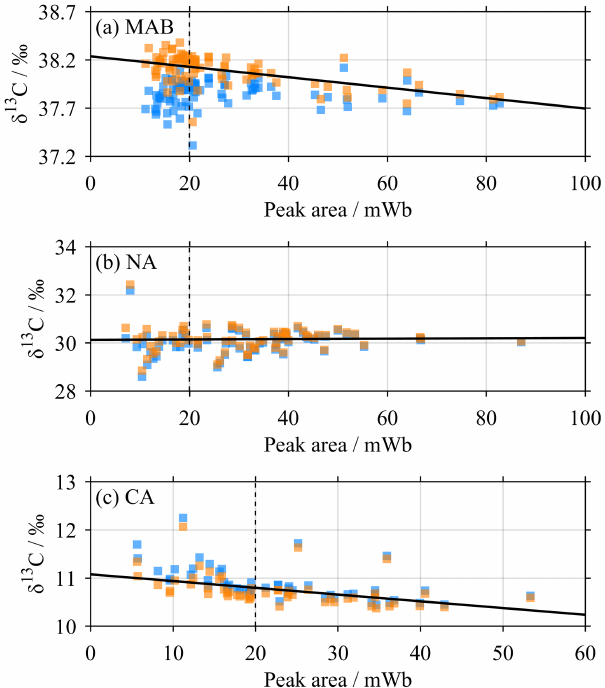
Figure 4. The blank correction for the standards. Each panel shows relationships between peak area and δ 13 C for (a) MAB, (b) NA and (c) CA before (blue) and after (orange) blank correction. The solid black lines are linear least-squares regressions for the data af- ter blank correction. Their intercepts with the dashed black lines at 20mWb were used as the mean values for each standard to gener- ate the V-PDB calibration curve (Fig. 5). Note that the panels have different axes resolutions.